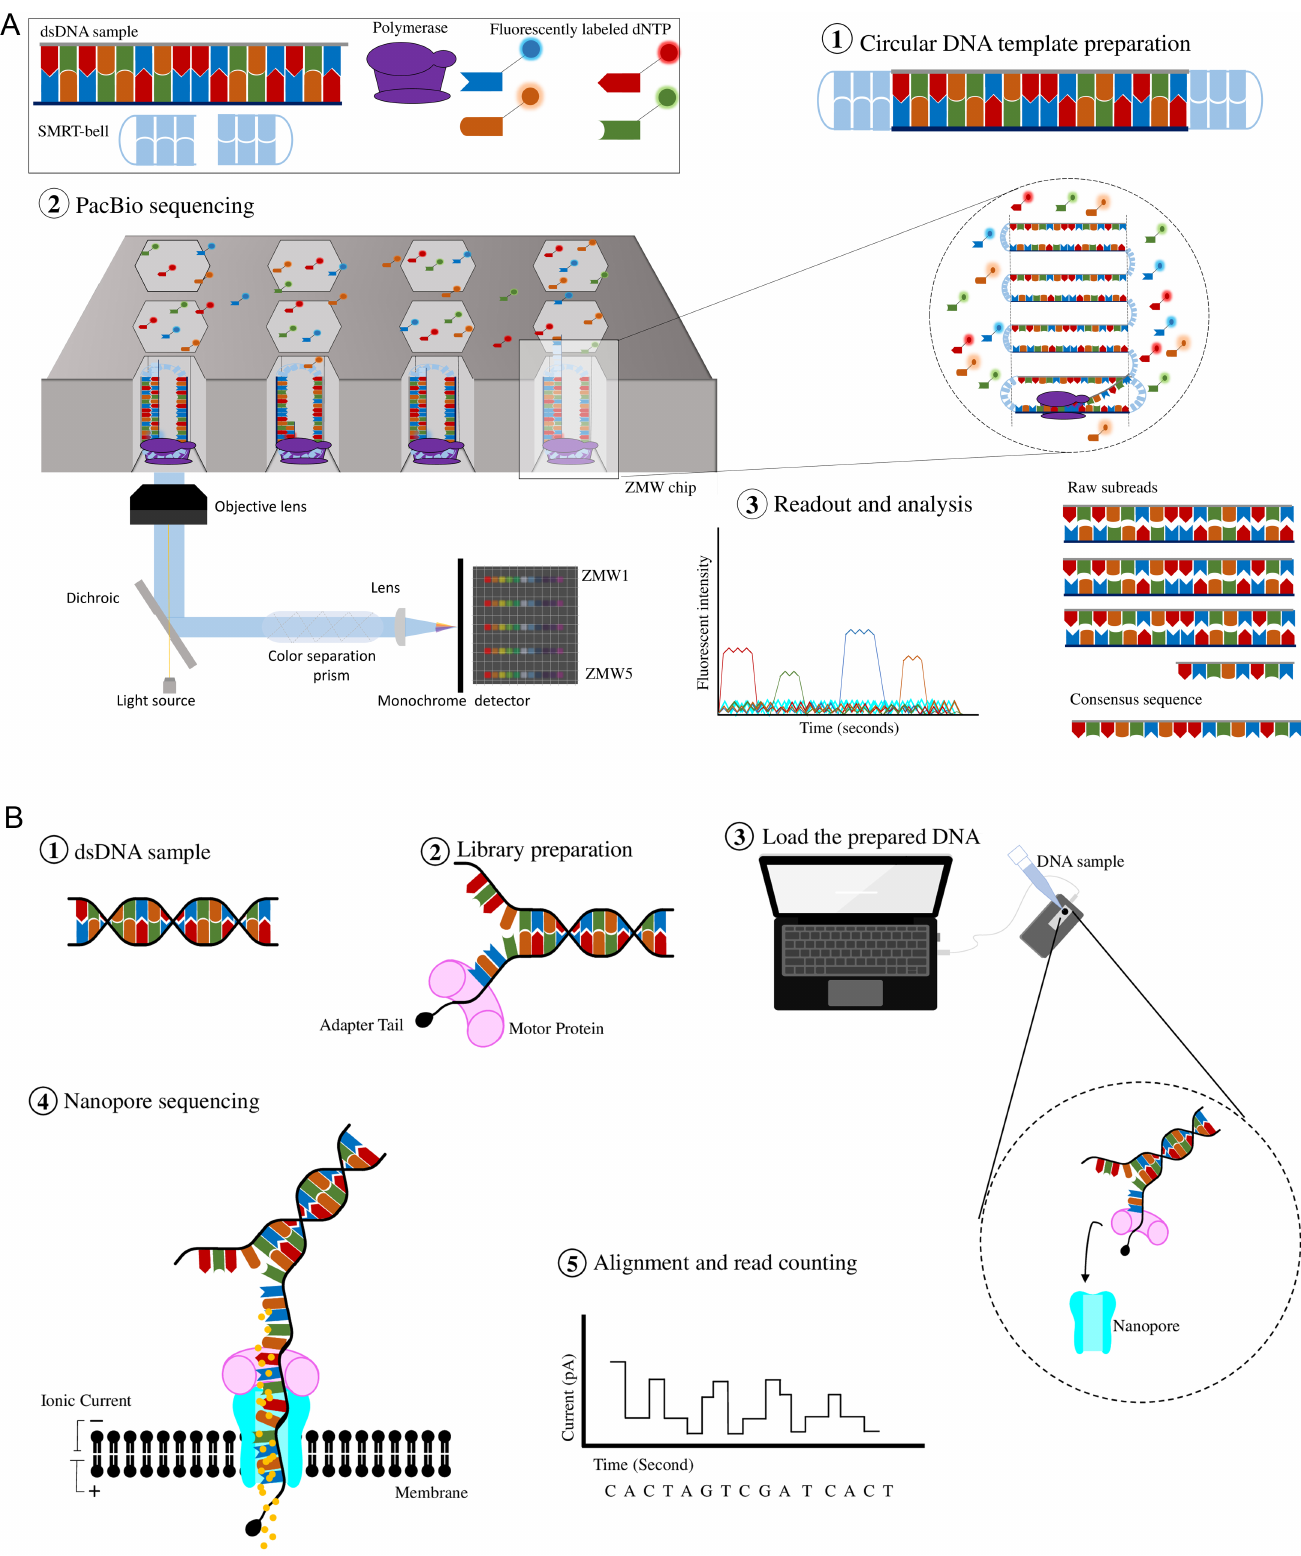
Figure 6. A,B. Third Generation Sequencing Methods; (A) the basic principle of PacBio sequencing method, (B) the Oxford nanopore technology method in its simple form (dsDNA: double-stranded DNA, SMRT: single molecule real-time, ZMW: zero mode waveguide, G: guanine, A: adenine, C: cytosine, T: thymine, pA: